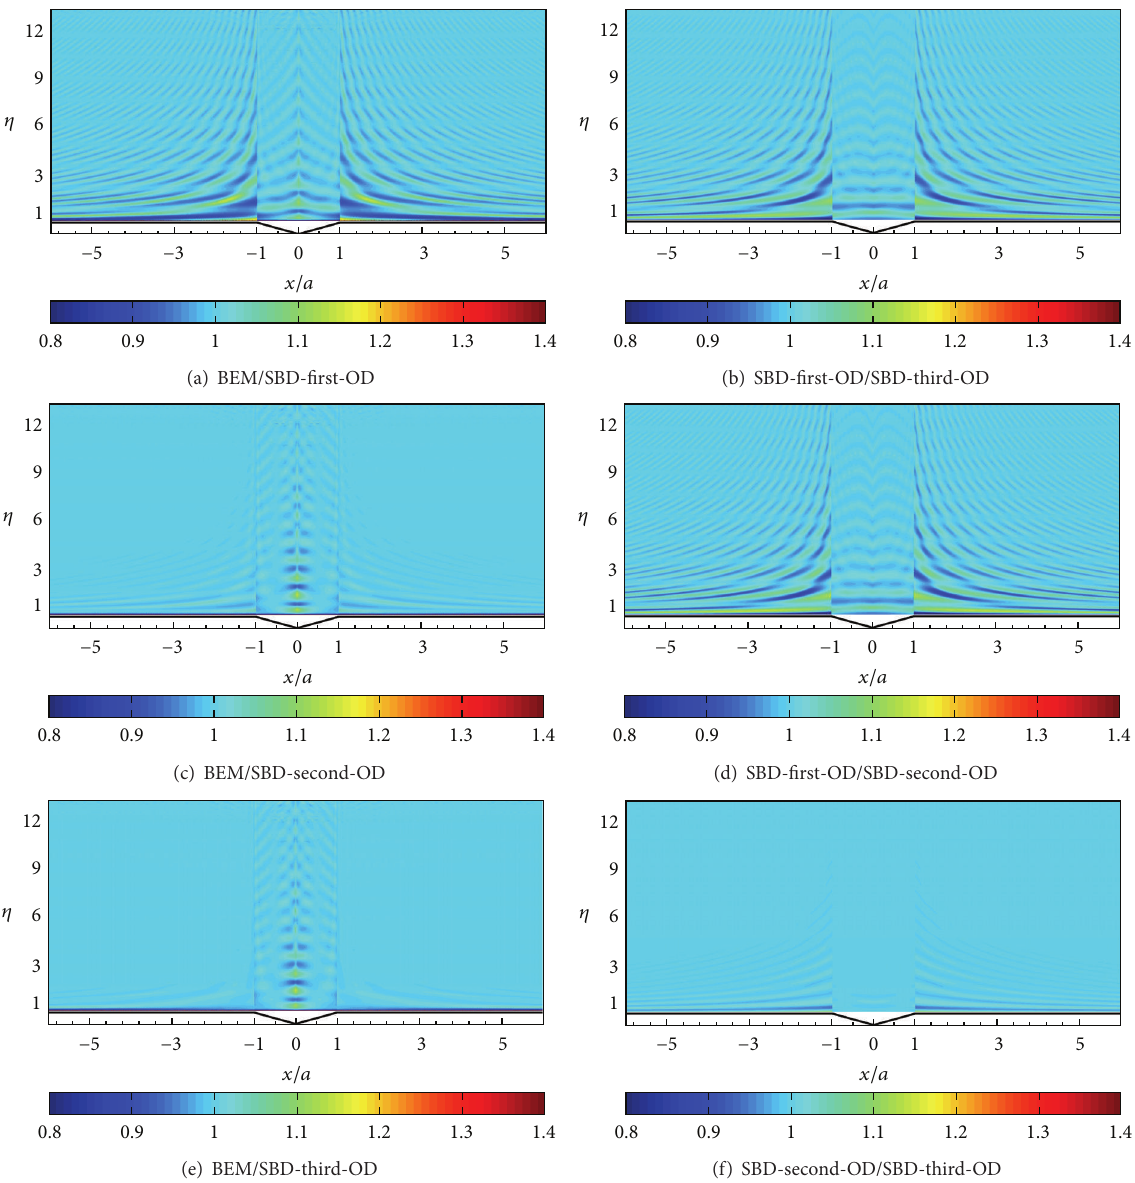
Figure 10: Contour maps for the BEM to SBD ratios for different orders of diffraction (column 1) and ratios between the SBD results with different orders of diffraction (column